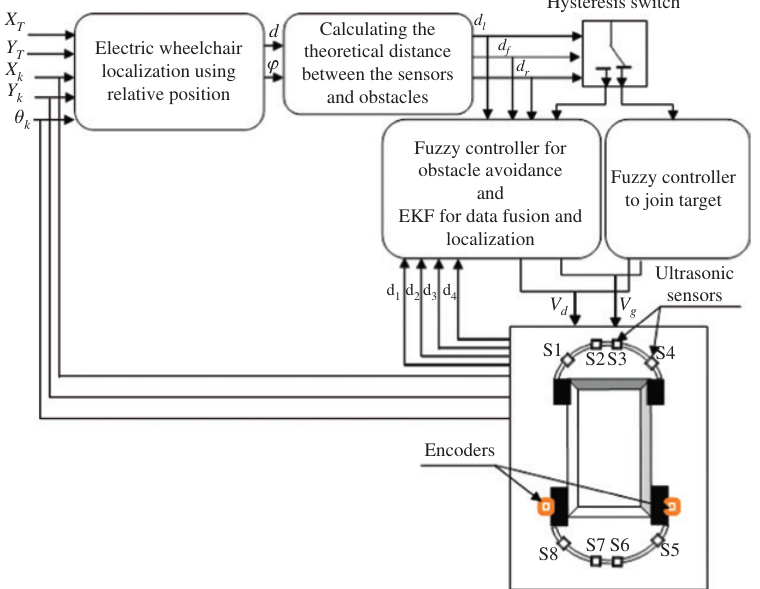
Figure 2: Global Control